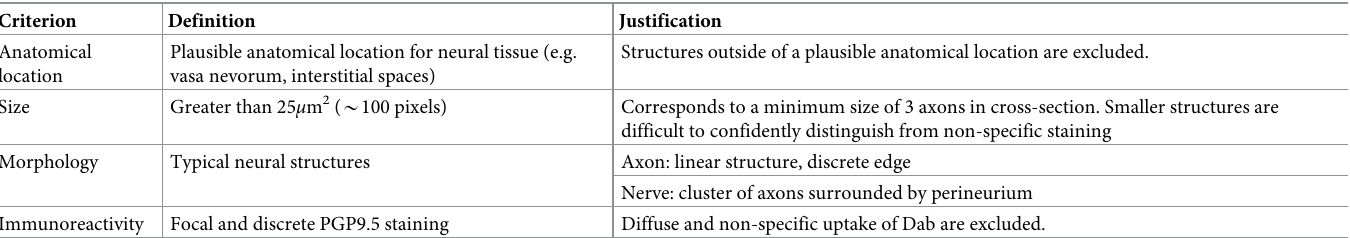
Table 1. Criteria for nerve